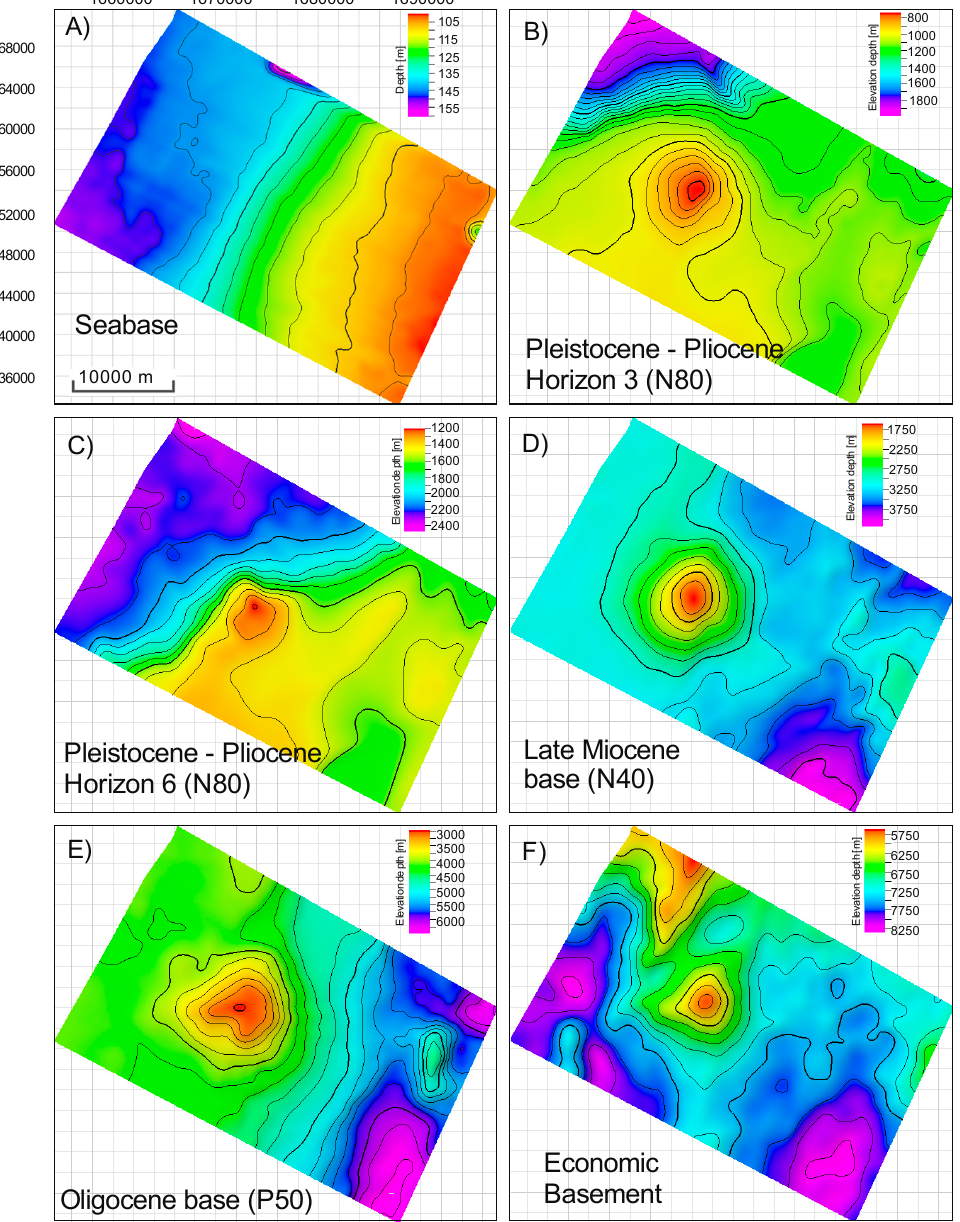
Figure 8. Selected depth maps for the interpreted horizons: ( A ) Seabase; ( B ) Pleistocene-Pliocene progradational system (Horizon 3); ( C ) Pleistocene-Pliocene progradational system (Horizon 6); ( D ) Late Miocene; ( E ) Oligocene base; ( F ) Economic basement.